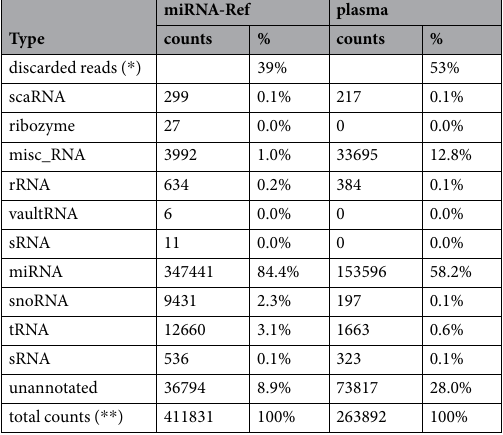
Table 3. Small RNA spectrum found in plasma and miRNA-Ref samples. ( * ) Unmapped reads and more than 2 multimaps of all sequenced reads. ( ** ) Counts includes only mapped reads with 2 or less multimaps. scaRNA: small-Cajal body-specific RNA; misc_RNA: miscellaneous RNA; rRNA: ribosomic RNA; sRNA: 5 S ribosomal RNA; snoRNA: small nucleolar RNA; tRNA: transfer RNA; snRNA: small nuclear RNA.